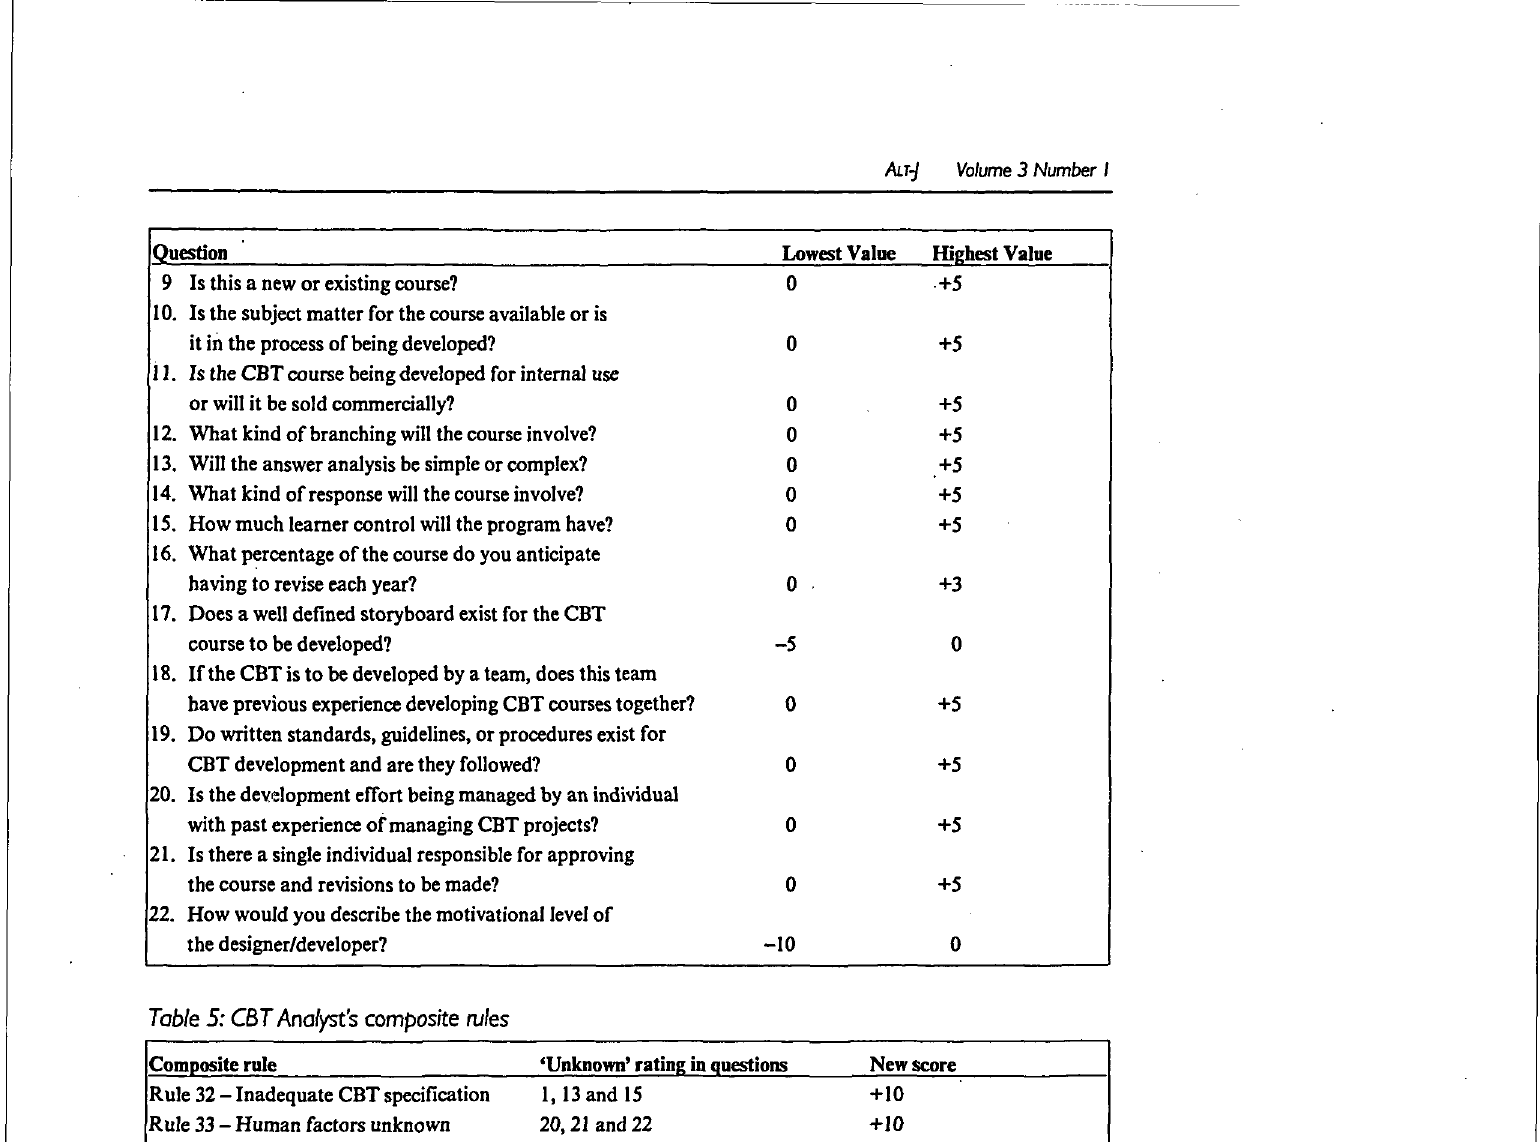
Table 5: CßT Analyst's composite rules Composite rule